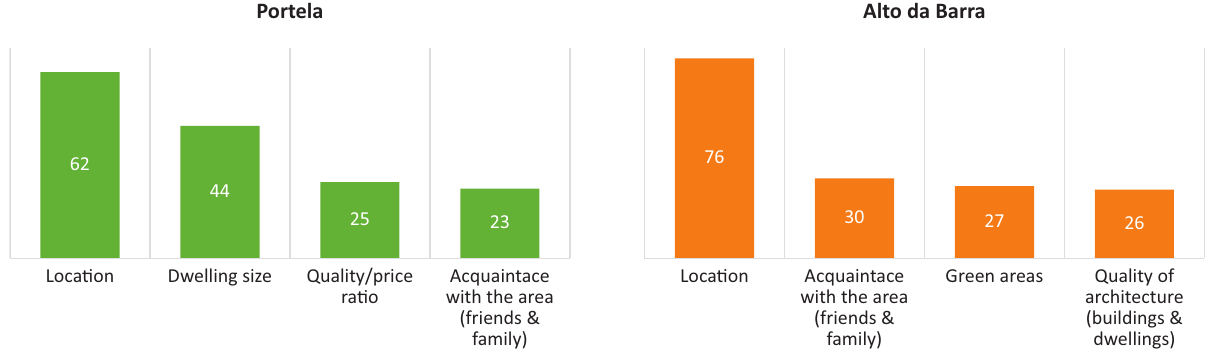
Figure 11. Residential satisfaction in Portela and Alto da Barra, in %. Source: Work based on the Population Surveys of Portela Urbanisation (2014) and the Population of Alto da Barra Urbanisation (2020) by Dinâmia’Cet. Source: Pereira and Corte‐Real